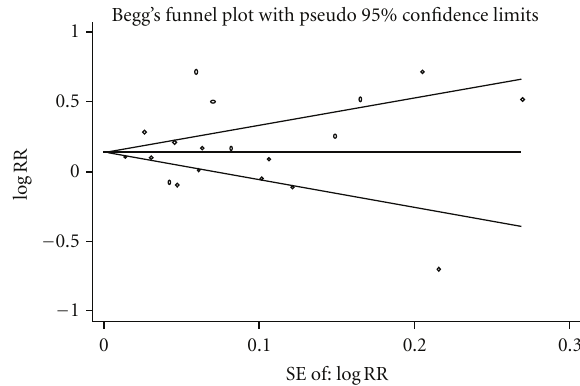
F 3: Funnel plot of Begg’s test (with 95 ence of publication